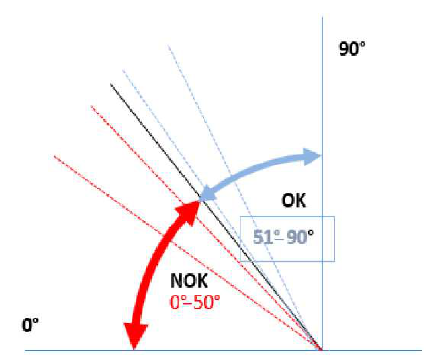
Figure 3. Evaluation criteria for textile laminate defects according to the standard.